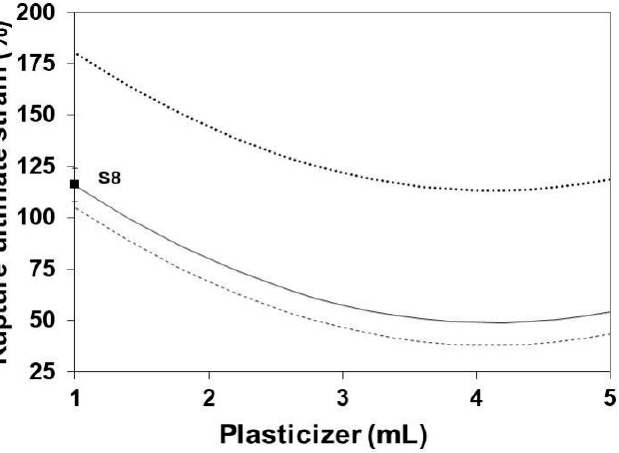
Figure 9. Effect of plasticizer on the RUS of SLGMs, varying the maturation time: 1.0 min (continu ‐ ous), 7.5 min (dashed) and 15.0 min (dotted). Experimental point: S8. Conditions: water content = 50 mL; gelatin content: 5.0 g.